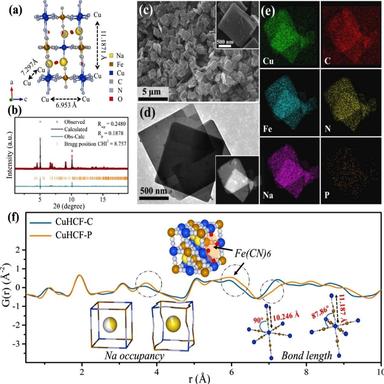
(a) Local structure of CuHCF-P was obtained by Rietveld refinement using the GSAS software. (b) Synchrotron X-ray diffraction (SXRD) pattern of CuHCF-P ( = 0.4427 Å). The red symbols (×) show the observed data, the black line is the calculated pattern, the orange bars are the position of the Bragg reflections, and the dark cyan pattern is the difference of the observed and calculate data. (c) SEM, (d) TEM, and (e) energy dispersive spectroscopy (EDS) mapping images of as-prepared CuHCF-P nano-sheets. (f) PD